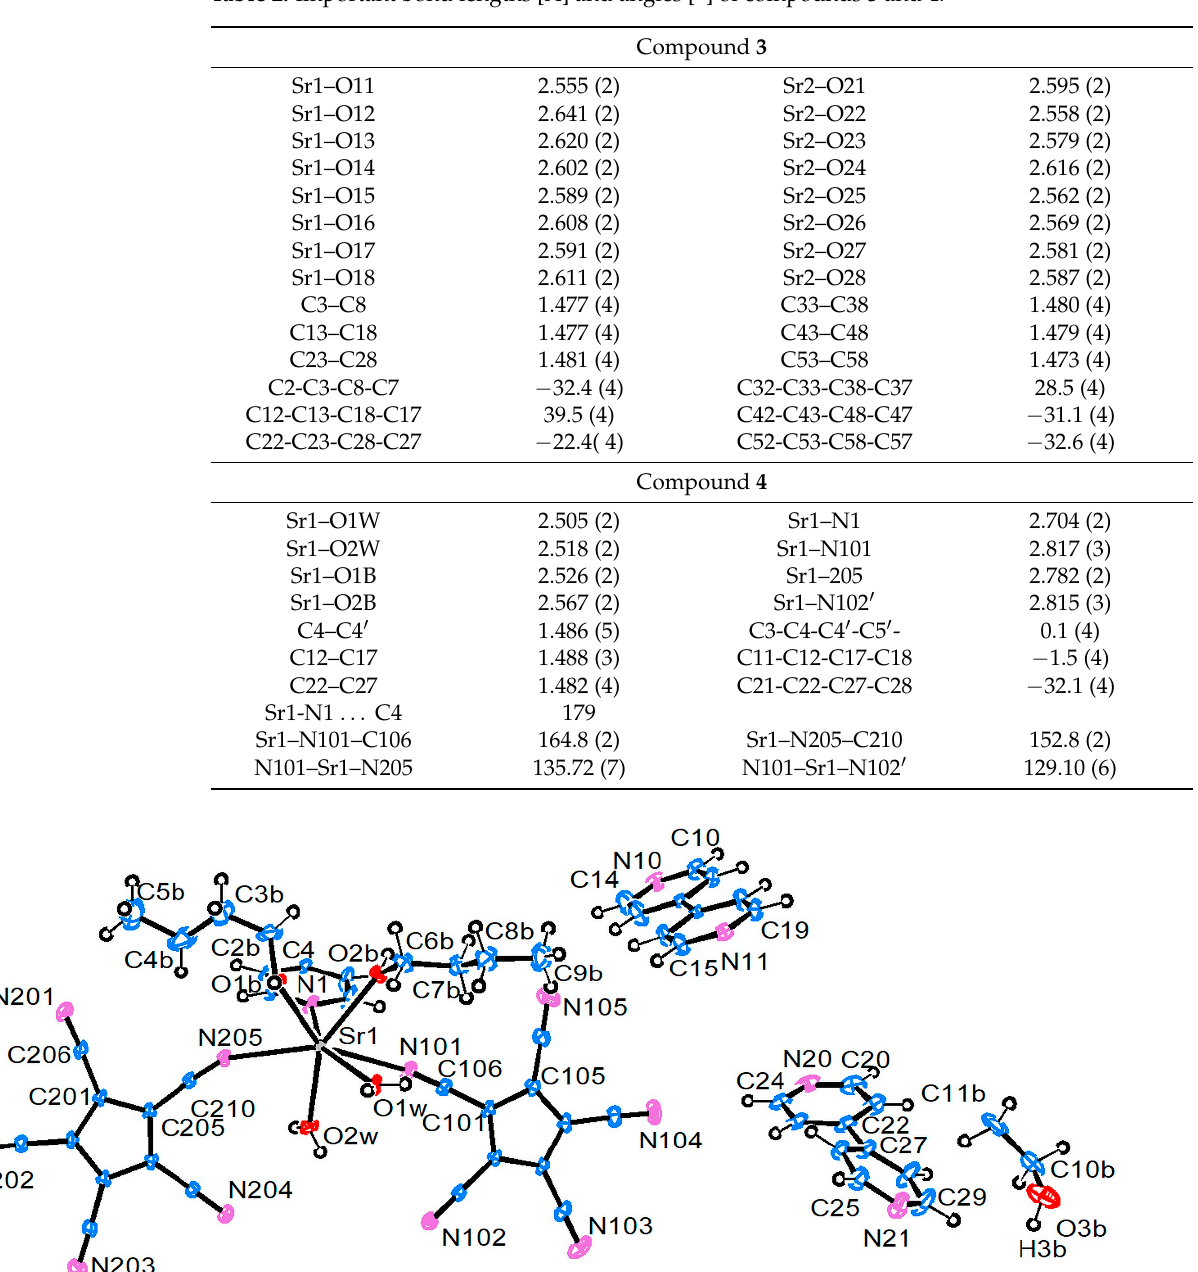
Table 2. Important bond lengths [Å] and angles [ ◦ ] of compounds 3 and 4 .